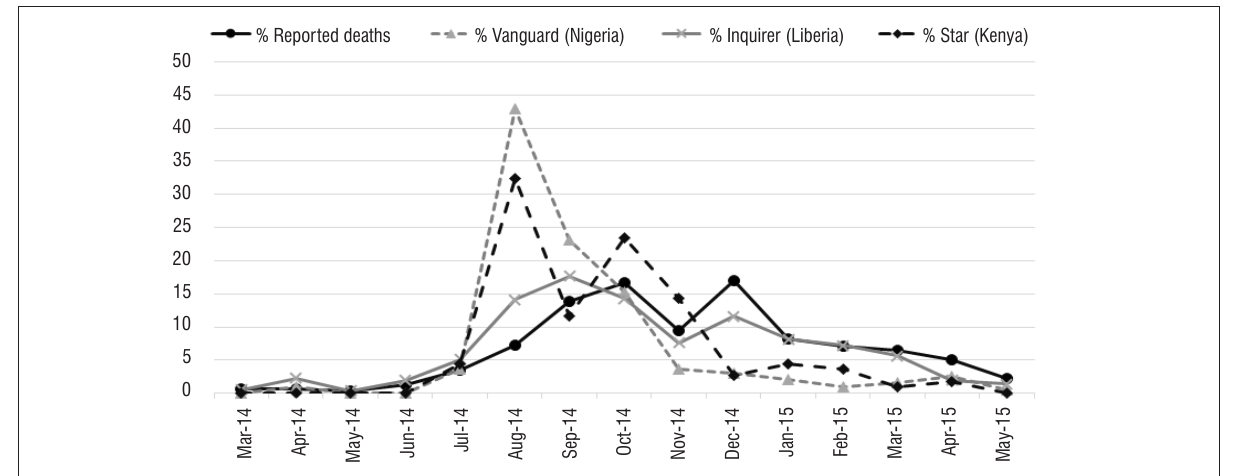
Newspaper coverage of Ebola and reported deaths ( n =1735